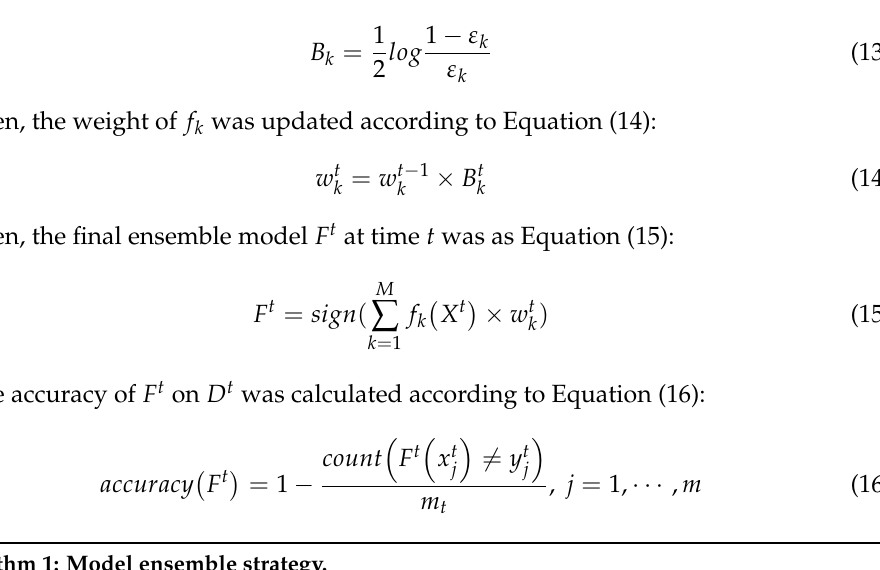
Algorithm 1: Model ensemble